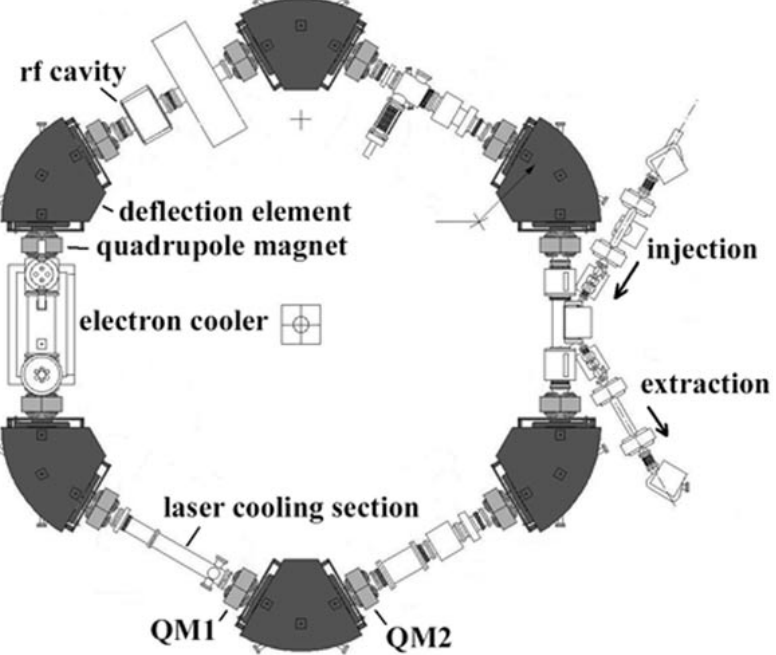
FIG. 3. The lattice structure of S-LSR. The number of the superperiod is 6. An rf cavity is introduced for beam bunching. Especially, in the case of only a magnetic storage ring, the rf cavity is also used for 3D cooling. For the dispersion-free condition, in addition to the rf cavity, a coupling rf cavity is to be installed for 3D cooling. In the horizontal beam dynamics, the radial focusing effect of the deflection element is utilized for beam focusing. Thus, all quadrupole magnets have diverging effect horizontally and focusing effect vertically.